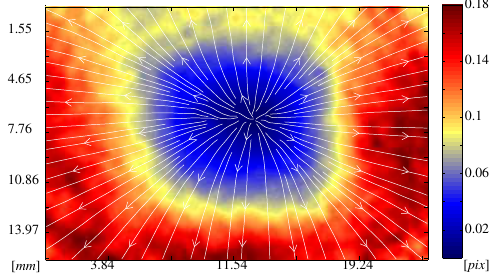
Figure 9: Color-shift estimation in pixels rooted from sub-pixel normalized cross=correlation (NCC) measurements for the red to blue colorband of the fixed-wing system.